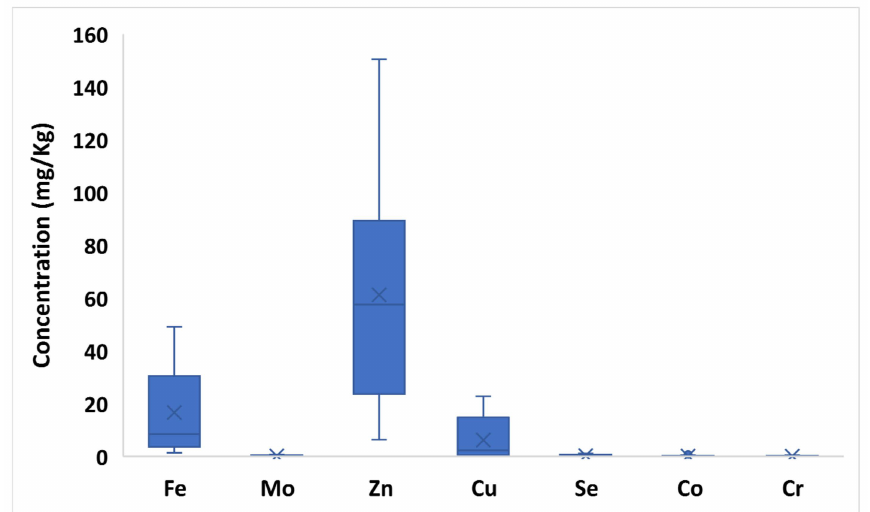
Figure 2. Box plot of essential trace elements (Fe, Mo, Zn, Cu, Se, Co, Cr) concentration in hemps. The “ × ” indicates the average value of each element.